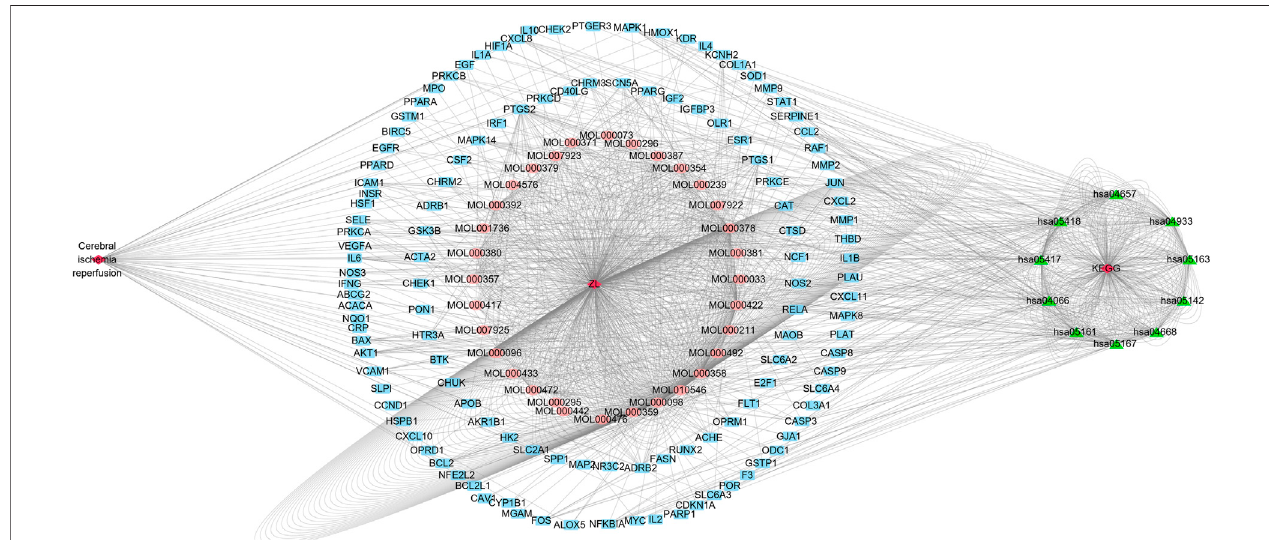
FIGURE 6 | Cytoscape diagram for cerebral ischemia – reperfusion, ZLH administration, and KEGG signaling pathways. The left exhibited cerebral ischemia – reperfusion disease and the middle was the MOL number from ZLH and associated 44 active components, whereas the outer blue circle was the common gene of cerebral ischemia – reperfusion and ZLH. Lastly, the fi rst 10 KEGG signaling pathways were put on the right side.